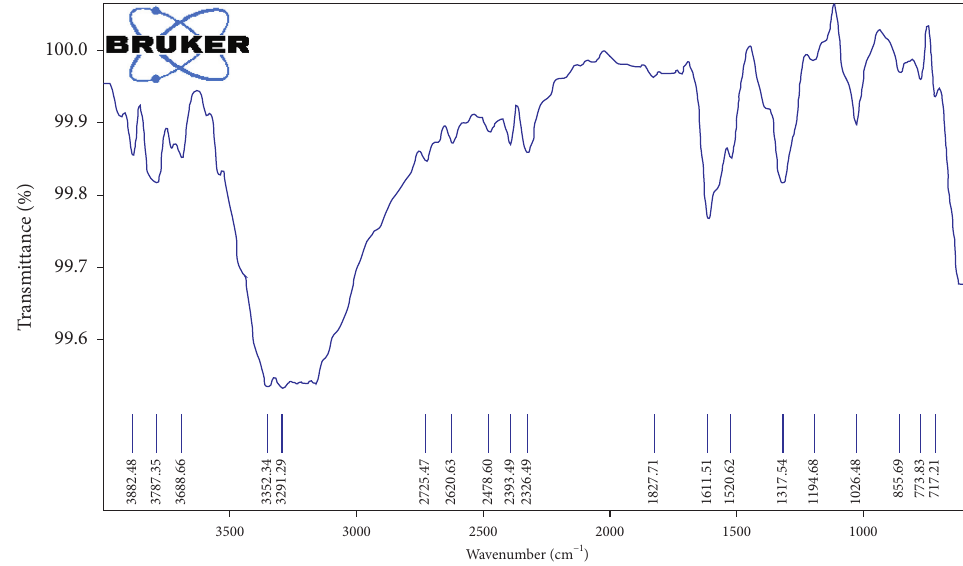
Figure 9: Fourier transform infrared spectra of